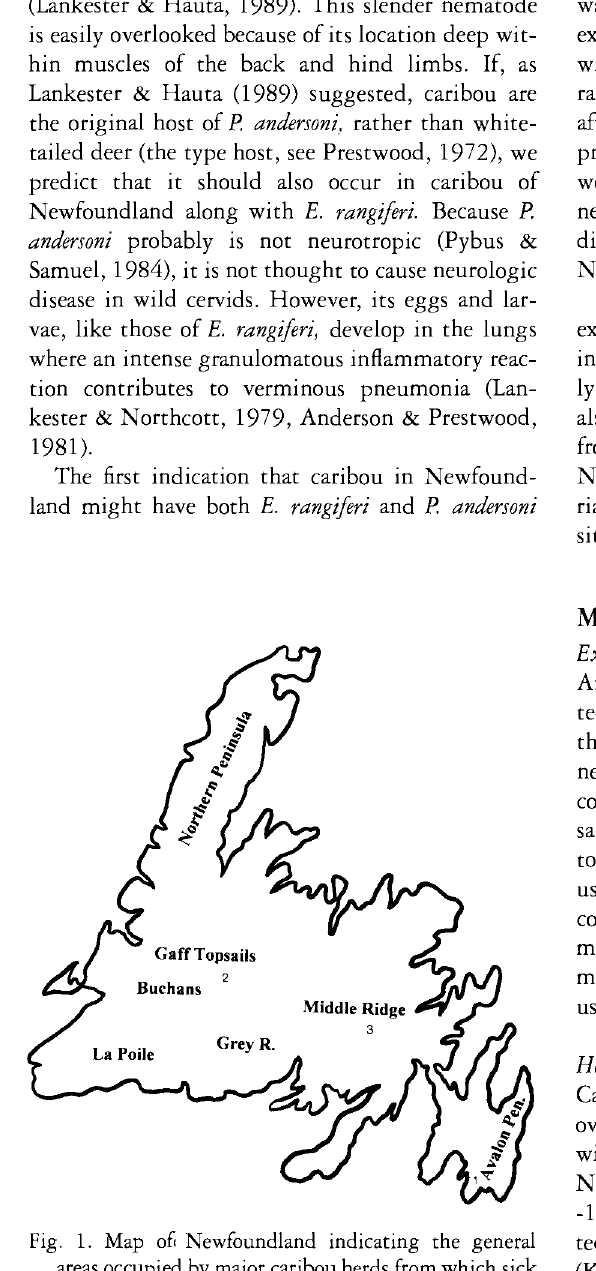
Fig. 1. Map of Newfoundland indicating the general areas occupied by major caribou herds from which sick caribou, moose, and fecal samples were